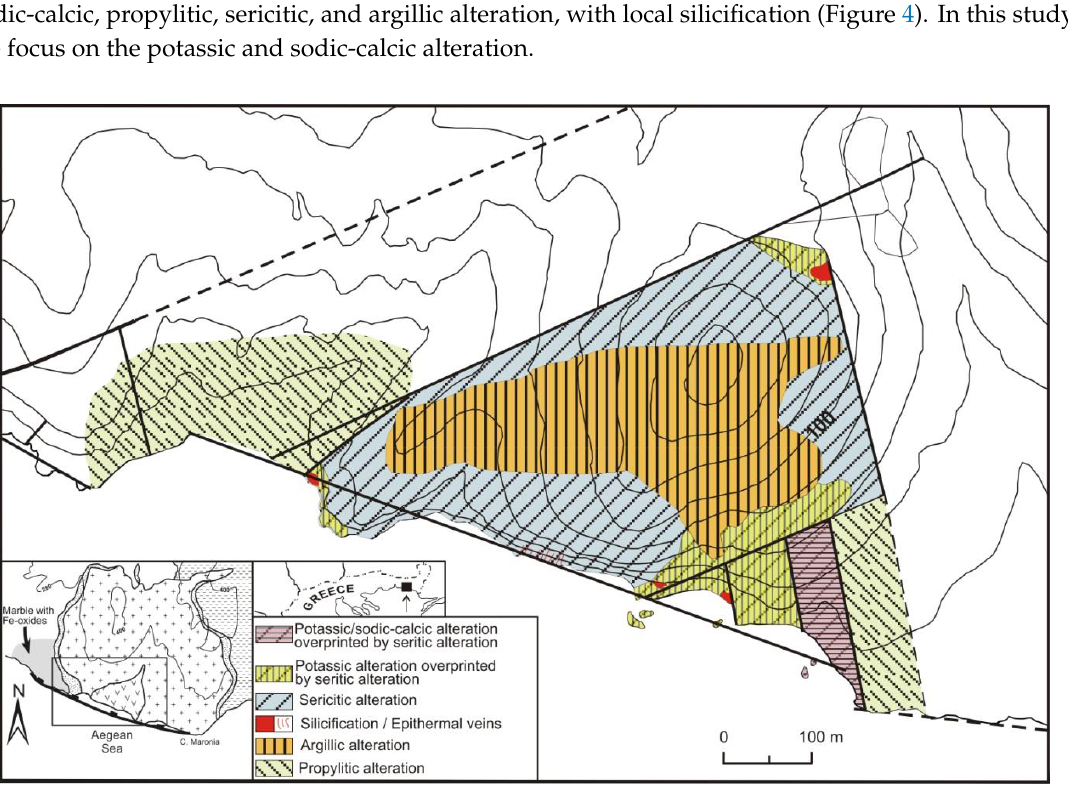
Figure 4. Distribution of the hydrothermal alteration zones at the Maronia porphyry system (modified after [11]).